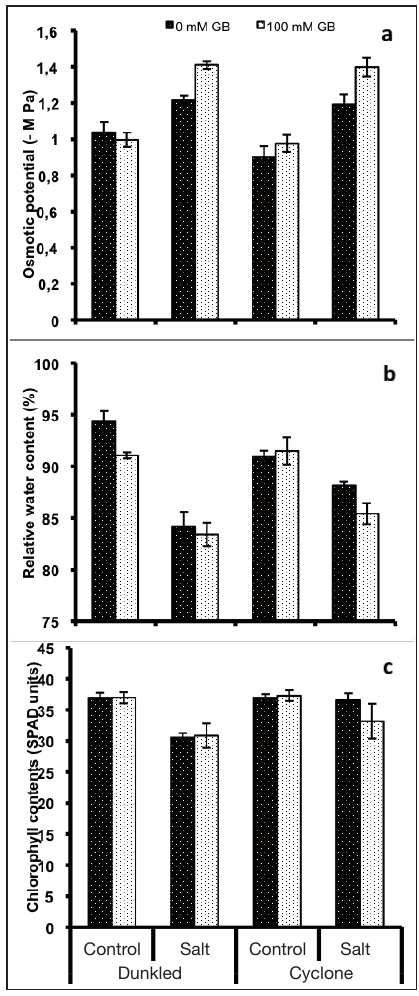
Fig. 2: Osmotic potential, relative water content and chlorophyll content of two cultivars of canola ( Brassica napus L.) when three week old plants were subjected to foliar application of glycinebetaine and salt stress for further two